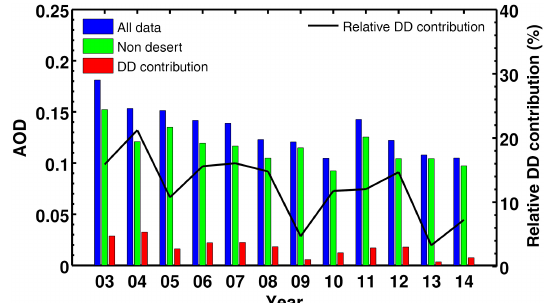
Figure 5. Interannual variability of DD contribution to the total yearly AOD in absolute (red bar) and relative values (black line). Blue bars (also indicated as all data) represent the mean yearly AOD value and green bars the corresponding values without including the days of desert dust (also indicated as non